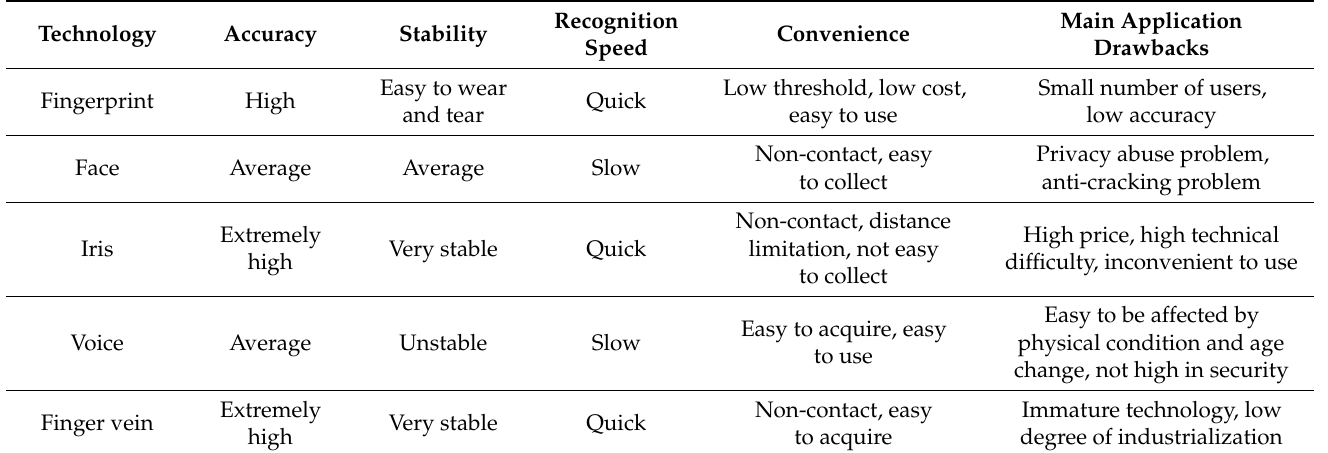
Table 1. Overview of mainstream biometric